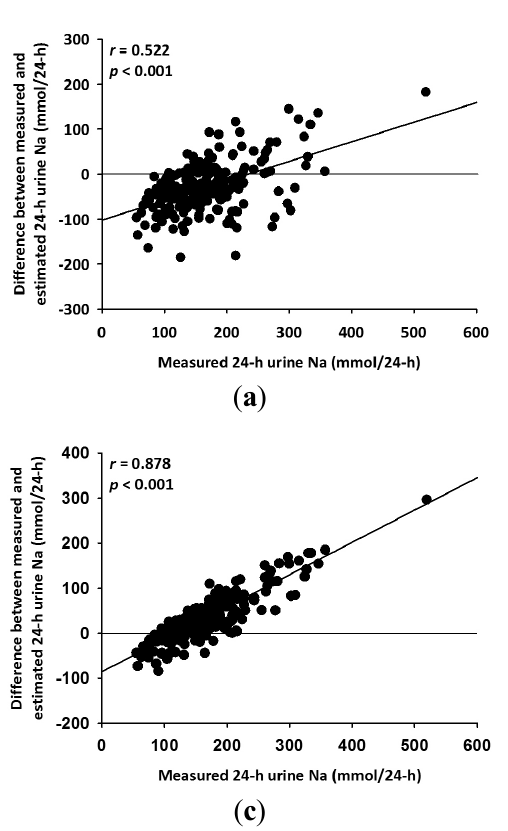
The difference between measured and estimated 24-HUNa significantly increased with increases in measured 24-HUNa, while it significantly decreased with decreases in measured 24-HUNa (Figure 5). Figure 5. Relationship between the differences of measured and estimated 24-hour urine sodium against measured 24-hour urine sodium. ( a ) Kawasaki’s equation; ( b ) Tanaka’s equation; ( c ) INTERSALT equation; ( d ) linear equation; ( e ) quadratic equation; and ( f ) cubic